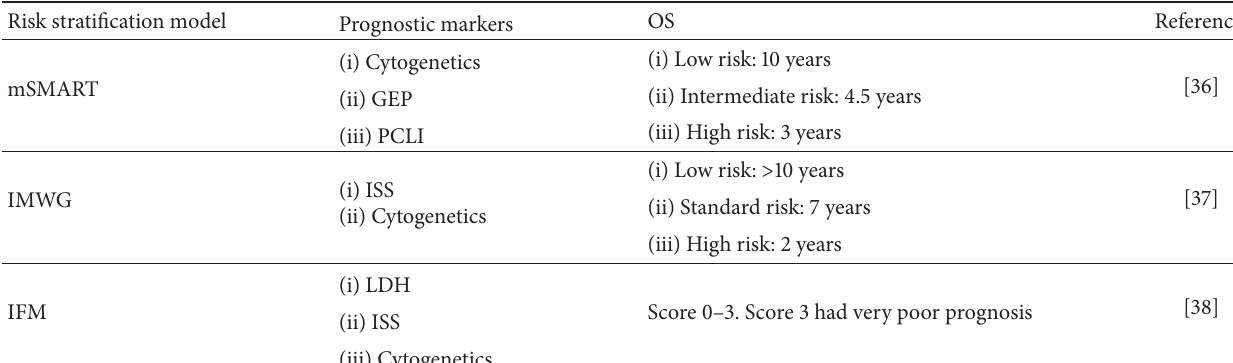
Table 1: Various risk stratification